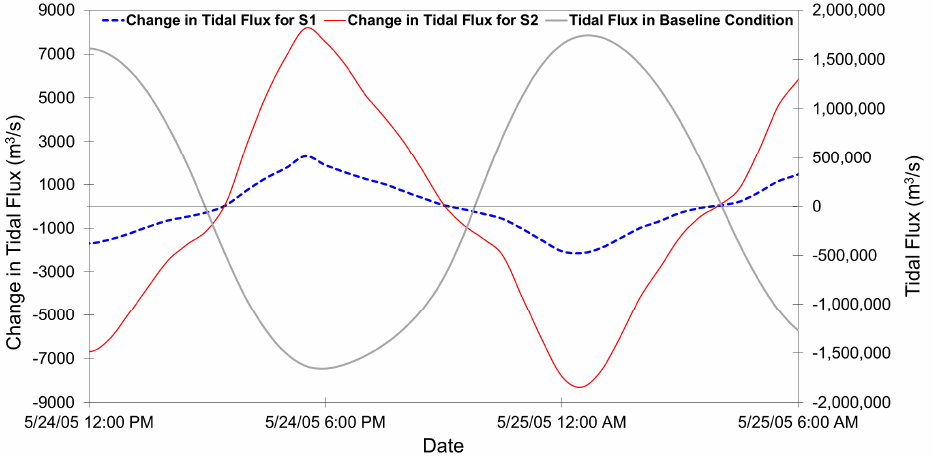
Figure 15. The change in tidal flux across the tidal farm transect near the Forelands as a result of energy extraction for two hypothetical tidal turbine farm scenarios (S1 and S2).